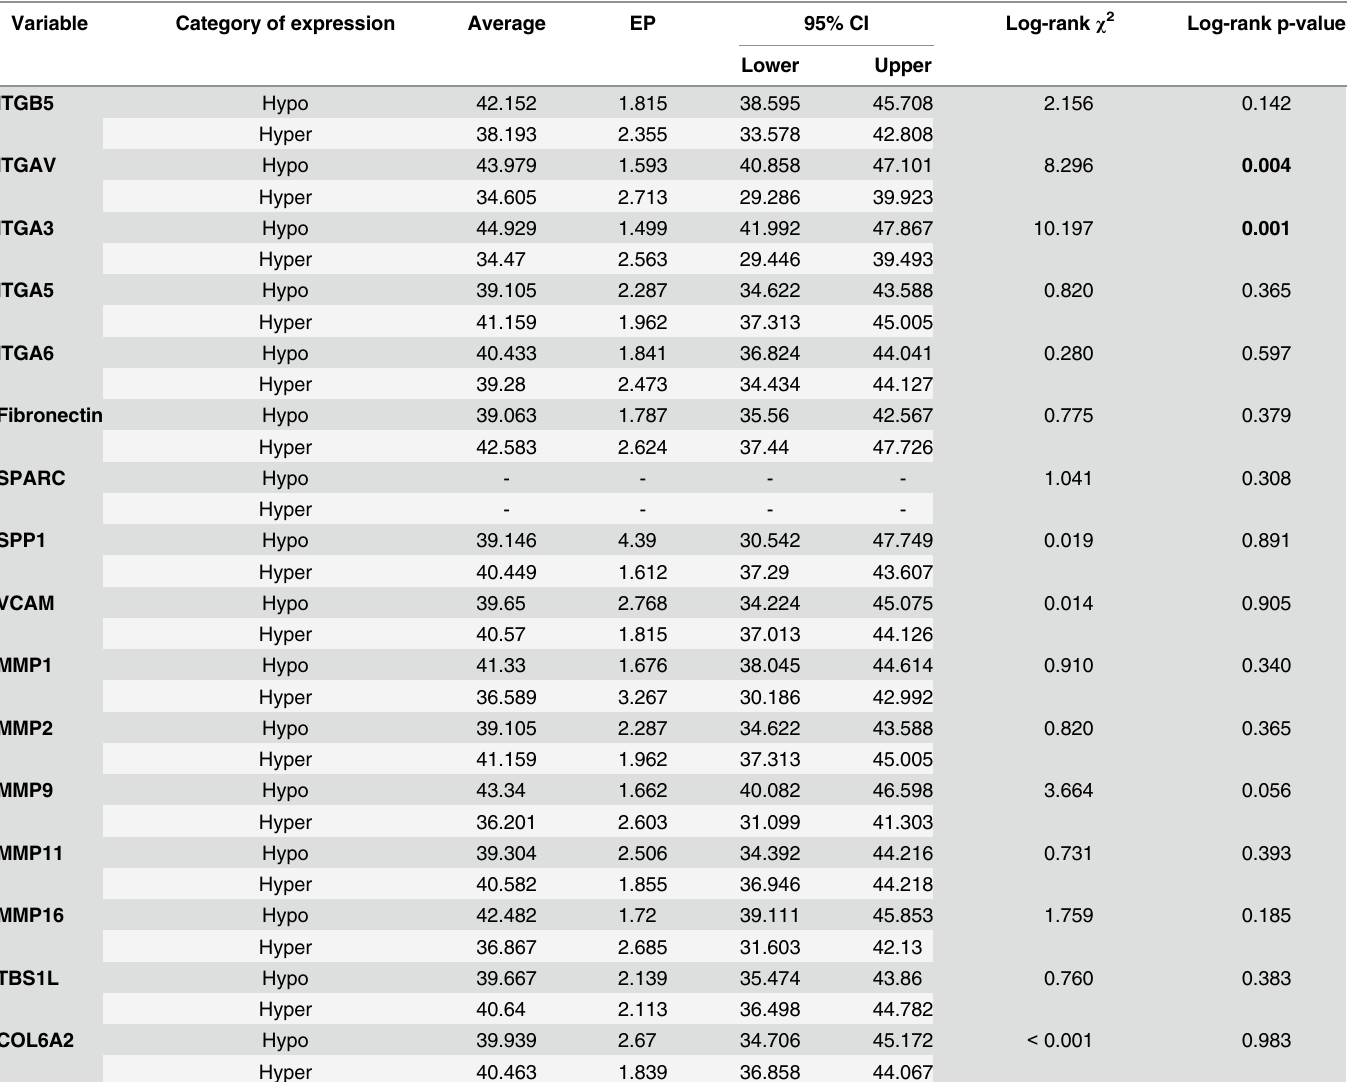
Table 4. Analysis of DFS in relation to expression of the ECM markers